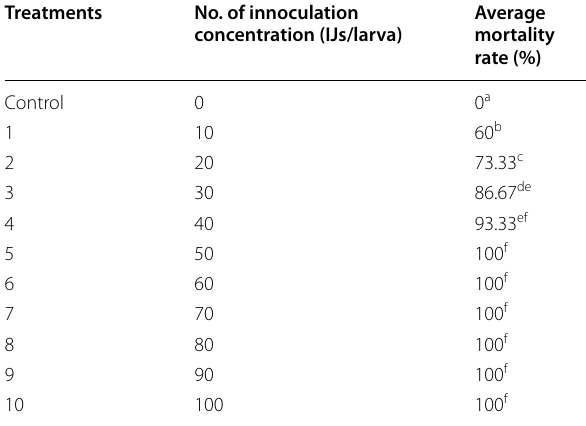
* Note: different superscript letters in the third column indicate significant difference